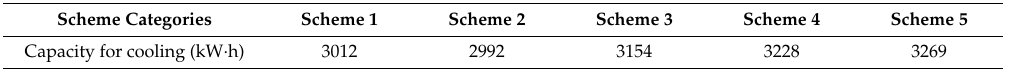
Table 4. Total capacity for cooling of the embedded tubes with varying distributions of the cooling time.